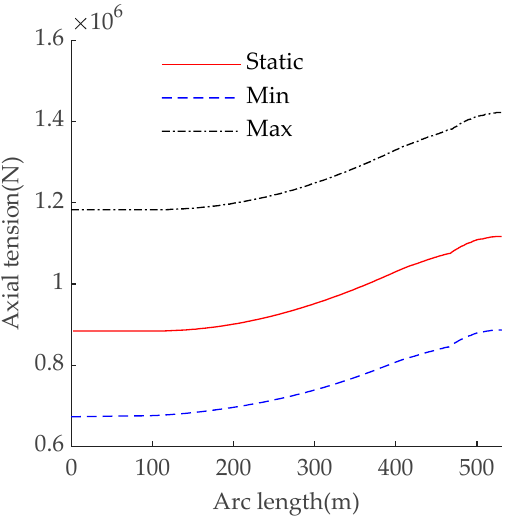
Figure 16. Comparison of axial tension forces.